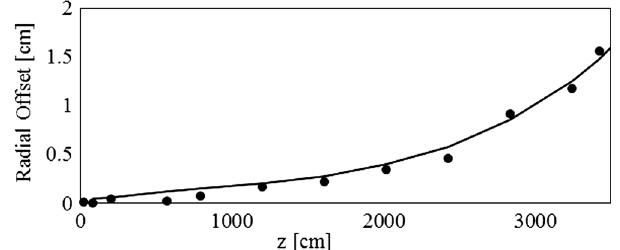
FIG. 3. Measured radial offset on Axis I (dots), and modeled IDI relying on the theory presented in Ref. [2] for an initial offset of 0.045 cm (solid line). The accuracy of the measurements is within 200 μ